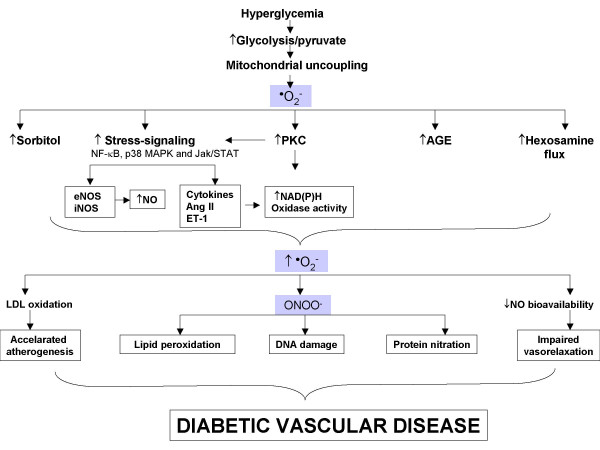
Current working model for the generation of reactive species and downstream targets in diabetes. Excess generation of mitochondrial ROS due to hyperglycemia initiates a vicious circle by activating stress-sensitive pathways such as NF-κB, p38 MAPK and Jak/STAT, polyol (sorbitol) and hexosamine pathways, PKC and AGEs. Enhanced production of AGEs, sorbitol and proinflammatory cytokines exerts a positive feedback on ROS and RNS synthesis and potentiates PKC-mediated vascular dysfunction by altering gene expression as well as vascular function and structure.